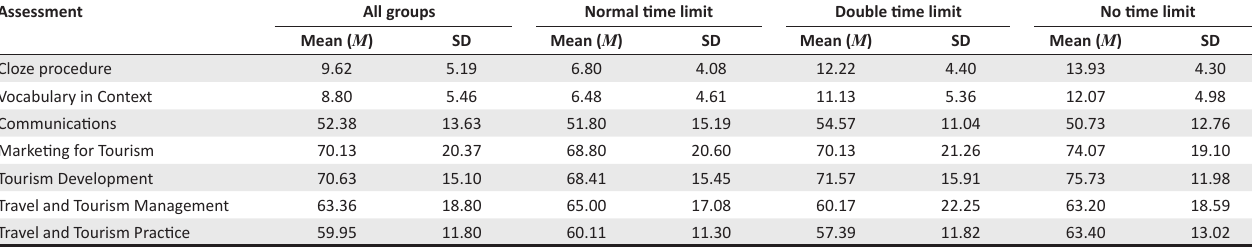
TABLE 1: Descriptive statistics for the English Literacy Skills Assessment tests and first-test subject marks by time-limit group.